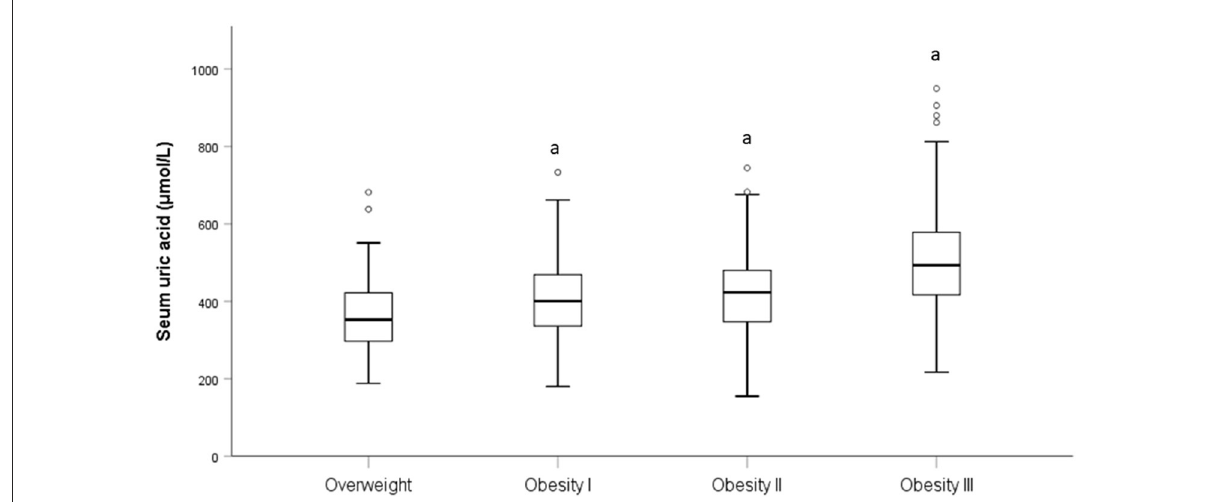
FIGURE1 Level of SUA in different BMI category. “a” is represent p < 0.001 when compared to the overweight category.